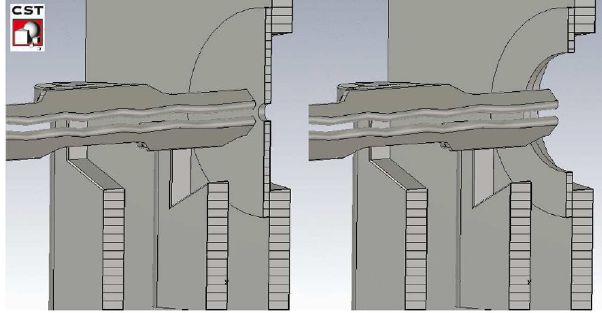
FIG. 20. Variation of the rf shielding insert ’ s opening radius in the simulation model.